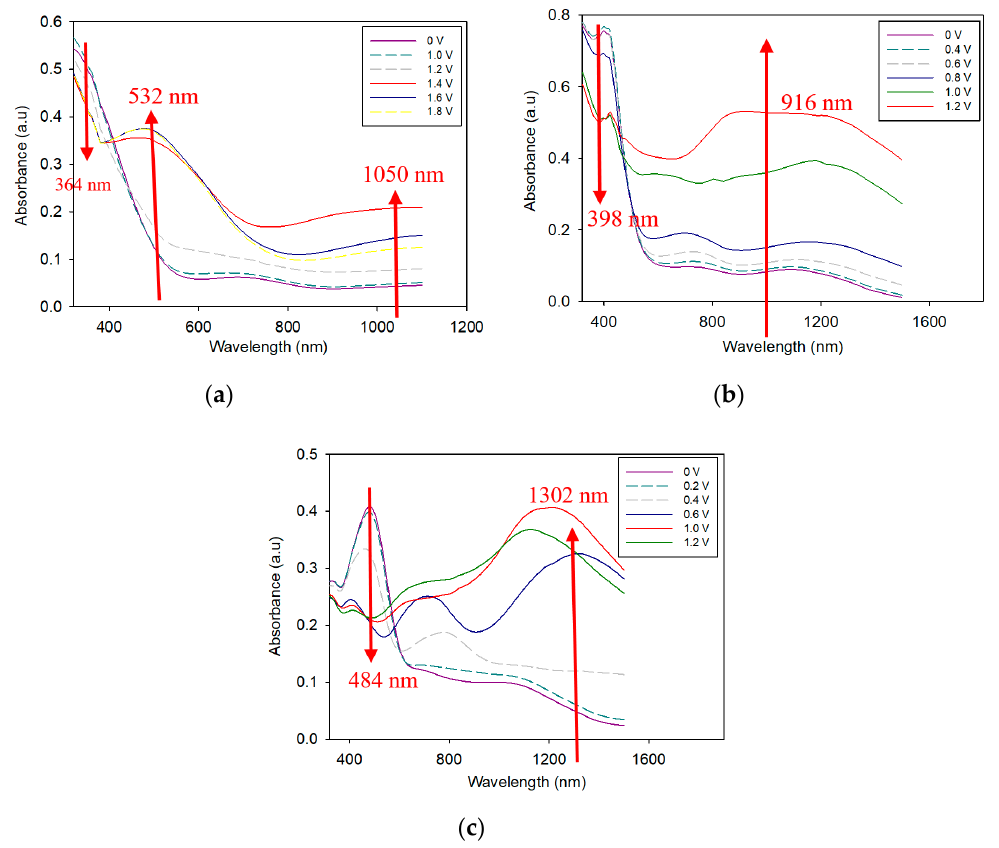
Figure 5. Absorption spectra of: ( a ) PTTPP; ( b ) P(TTPP- co -DTC); and ( c ) P(TTPP- co -DTP) films at different voltages.